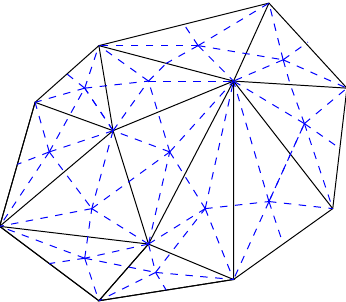
Figure 2. Powell–Sabin refinement of the given